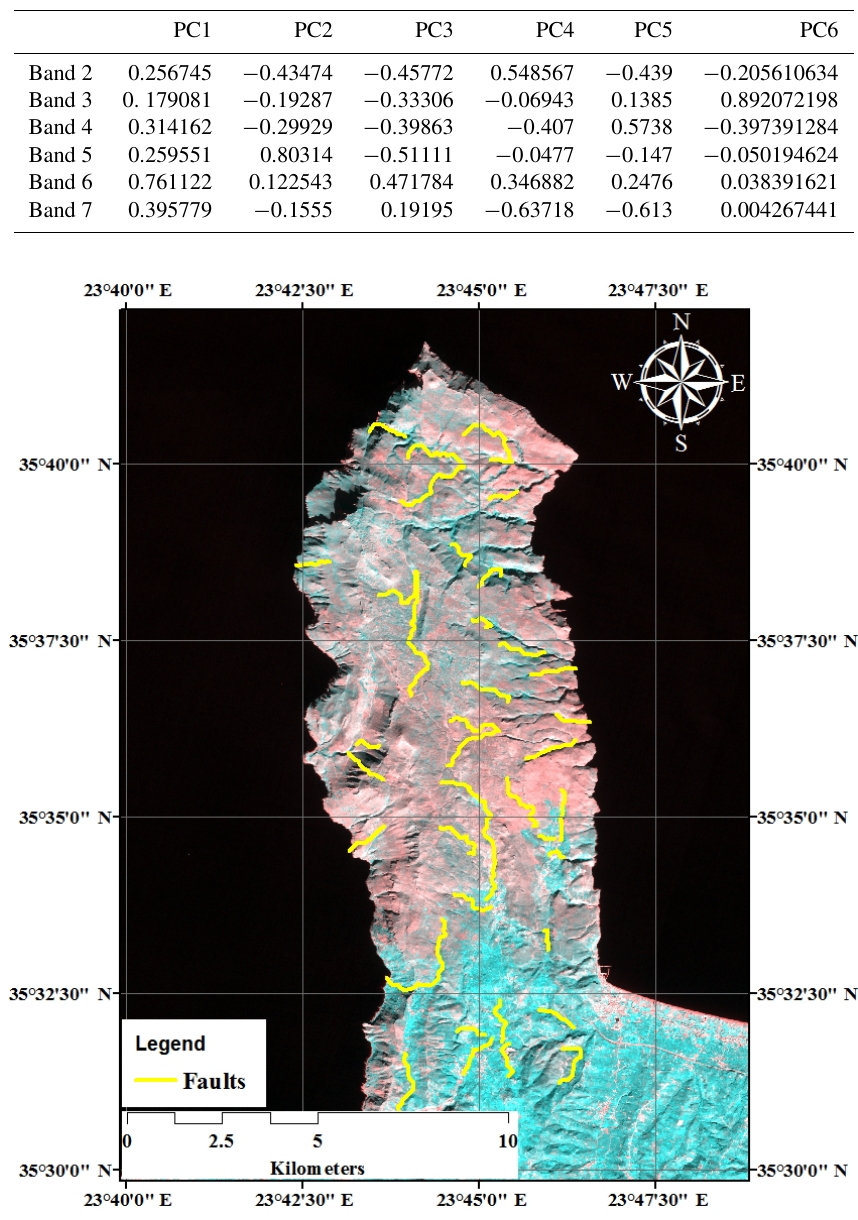
Figure 4. Fault detection using false color composition